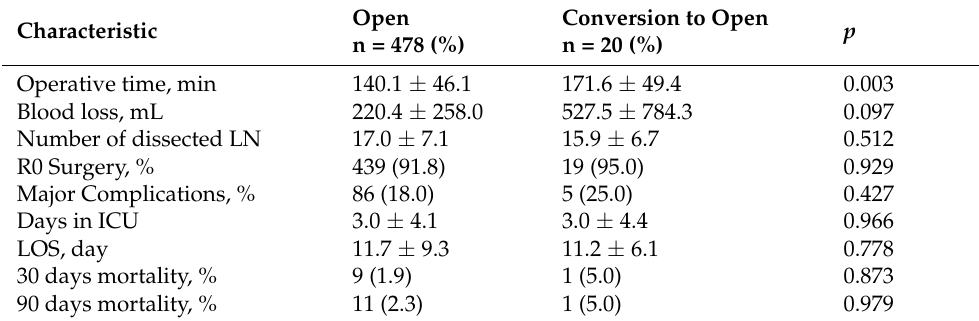
Table 3. Perioperative outcomes between Open pneumonectomy and VATS conversion to open patients. Characteristic